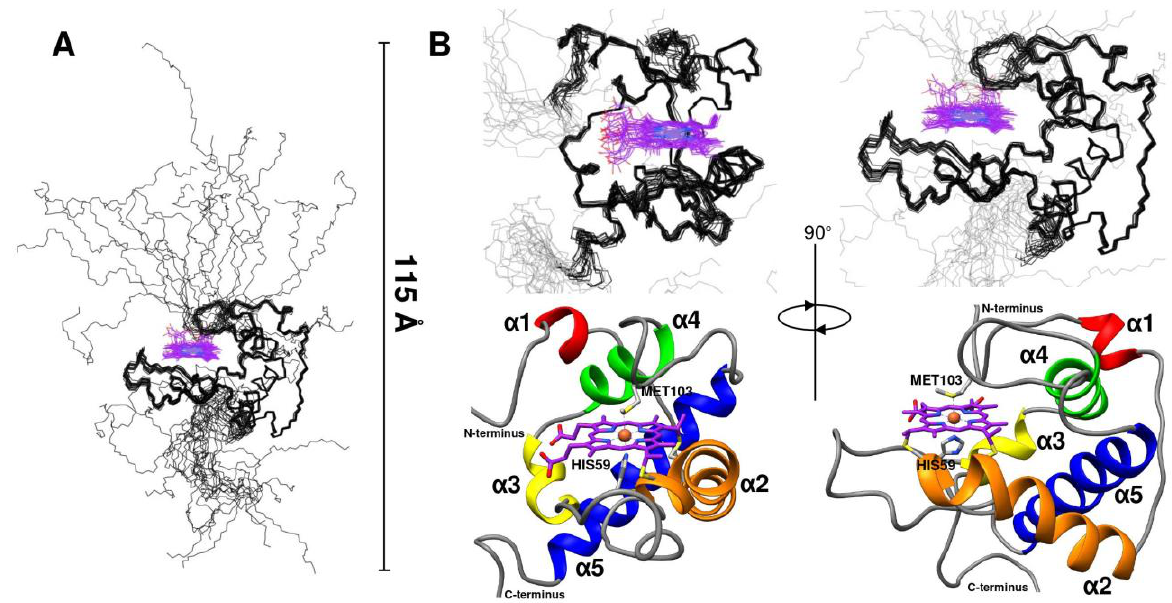
Figure 3. Solution NMR structure of oxidized CytC552. ( A ) Graphical representation of backbone overlay for the final ensemble of 20 structures (carbon atoms of the heme c group are colored in violet). Maximum size of polypeptide chain is indicated by scale bar. ( B ) Main-chain representation (in two projections) of globular part of NMR ensemble (top) and ribbon representation of lowest energy structure with the α -helices highlighted by contrast colors (bottom). Heme ligating Cys55 and Cys58 residues, and axial coordinating His59 and Met103 residues are shown with sticks.